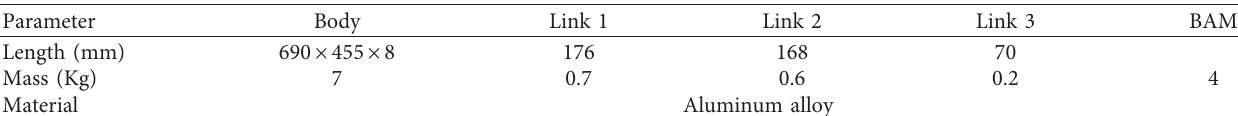
Table 3: Parameters of chassis